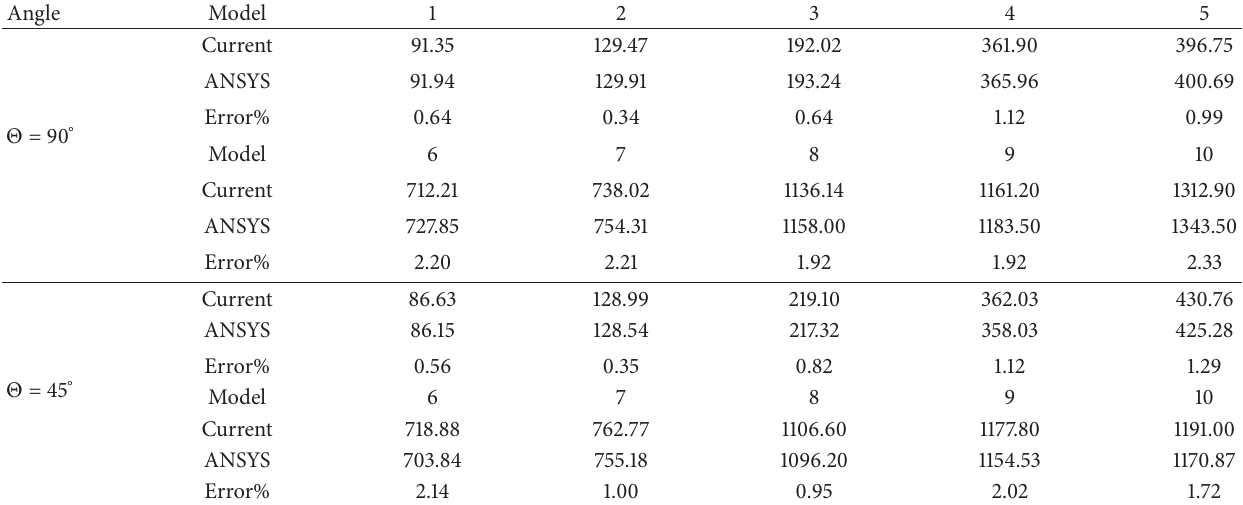
Table 4: The natural frequencies for the coupled beams with 90 ∘ and 45 ∘ coupling angle